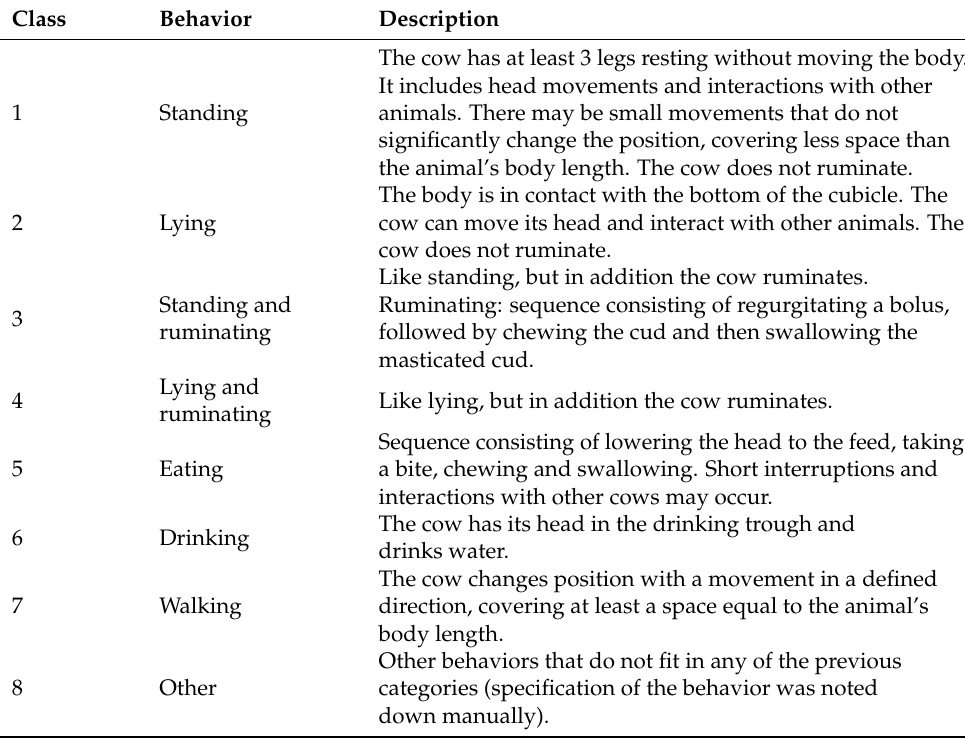
Table 1. Ethogram of the studied cow behaviors. Class refers to the encoded button that was pushed during observations and to the identification of the behavior during the algorithm development.